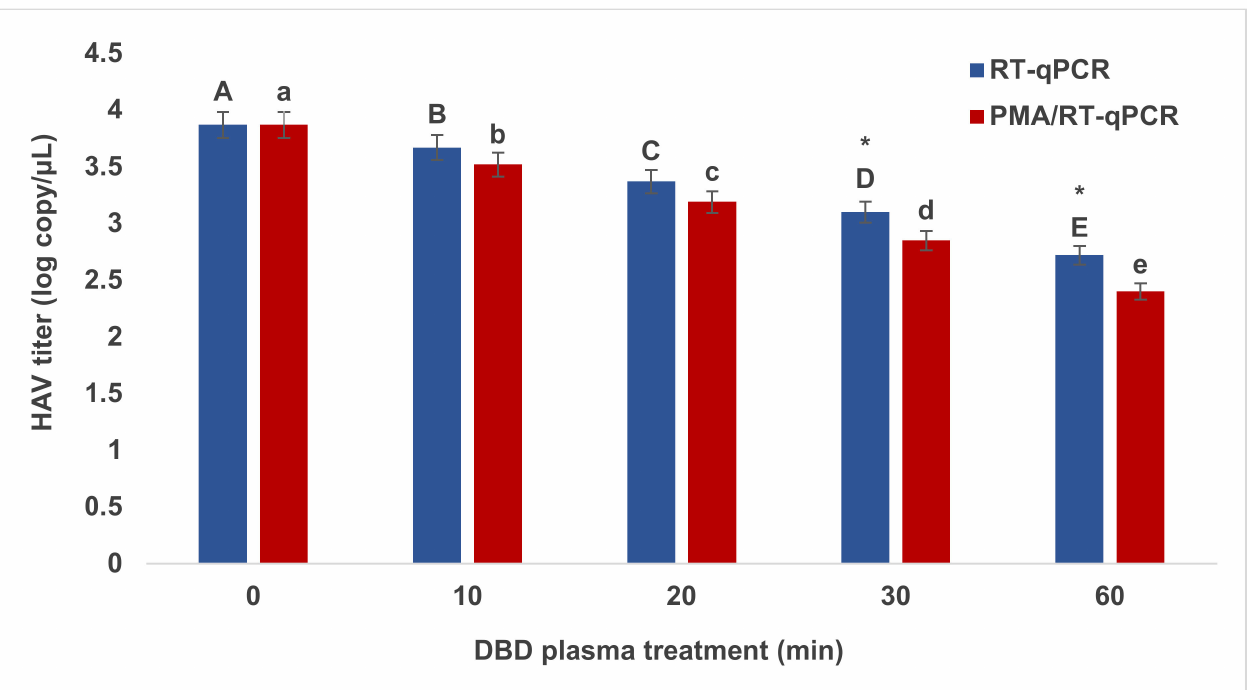
Figure 1. Comparison of HAV values in PBS suspension between RT-qPCR and PMA/RT-qPCR analysis by DBDP. Error bars indicate standard deviations of the mean of three samples per treatment. The different letters indicate significant differences at untreated samples (A–E) or PMA-treated samples (a–e) using Duncan’s multiple range test ( p < 0.05). Asterisks (*) indicate significant difference between untreated and PMA-treated samples by t -test ( p < 0.05).